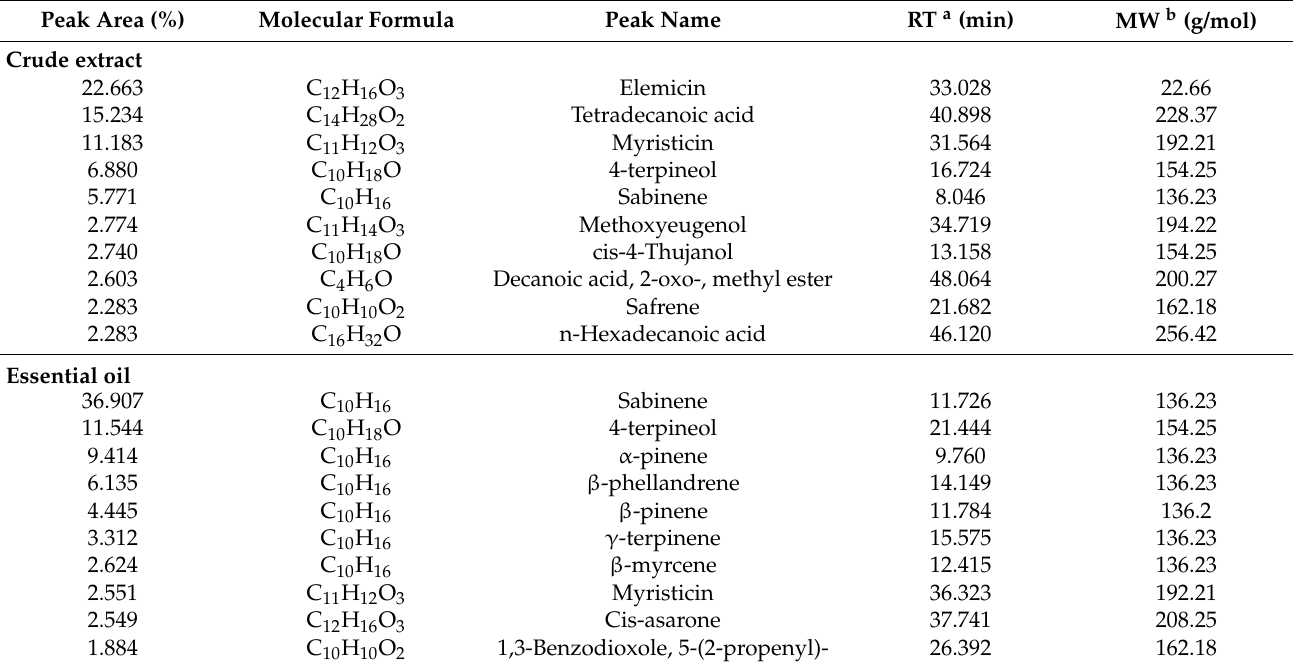
Table 2. Chemical composition in the crude extract and essential oil identified by GC/MS.